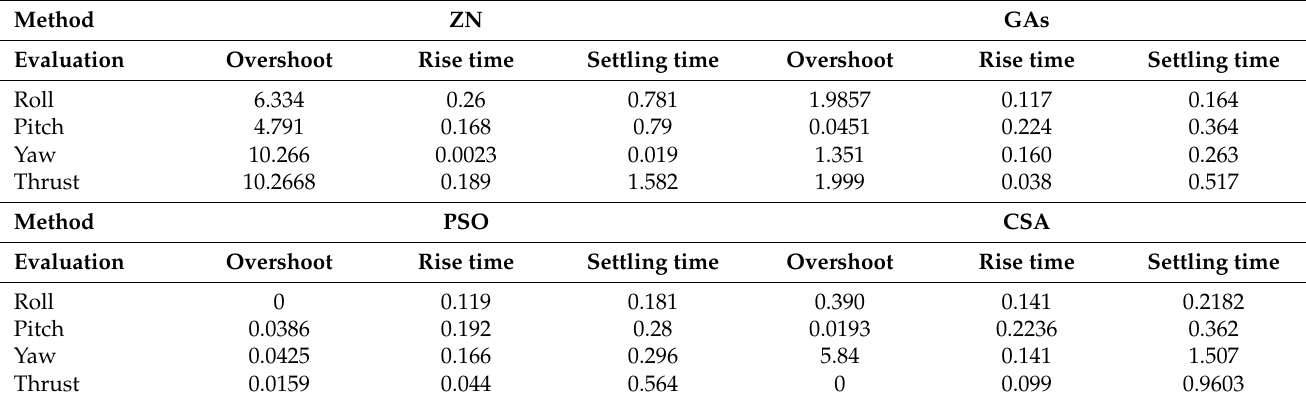
Table 2. Overshoot, rise time and settling time obtained by ZN, GAs, PSO and